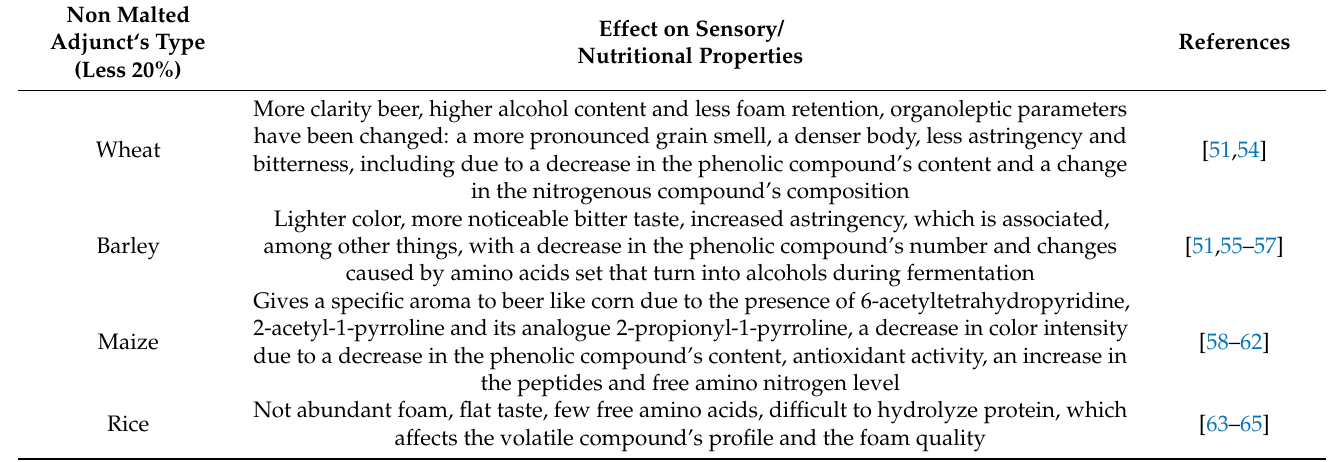
Table 3. The influence of adjuncts on beer